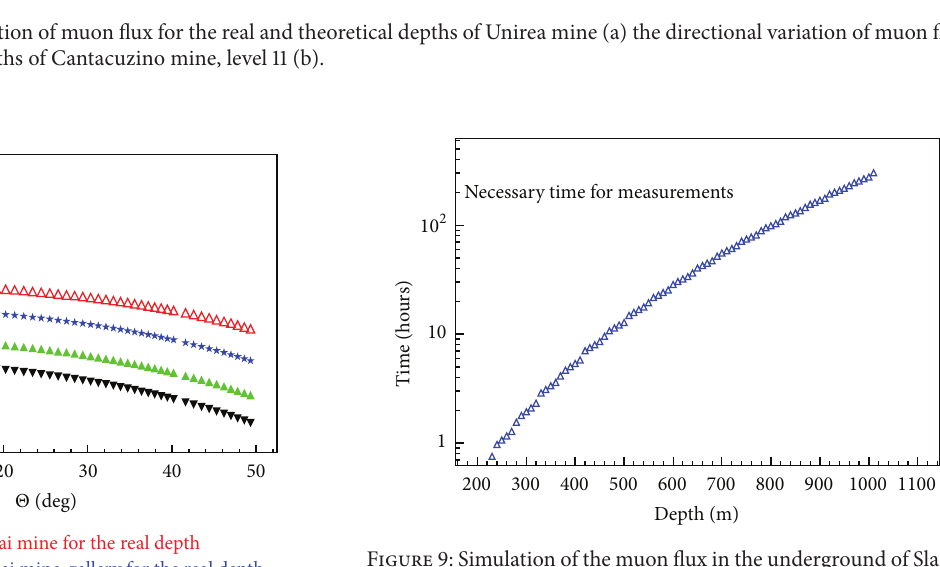
Figure 9: Simulation of the muon flux in the underground of Slanic Prahova salt